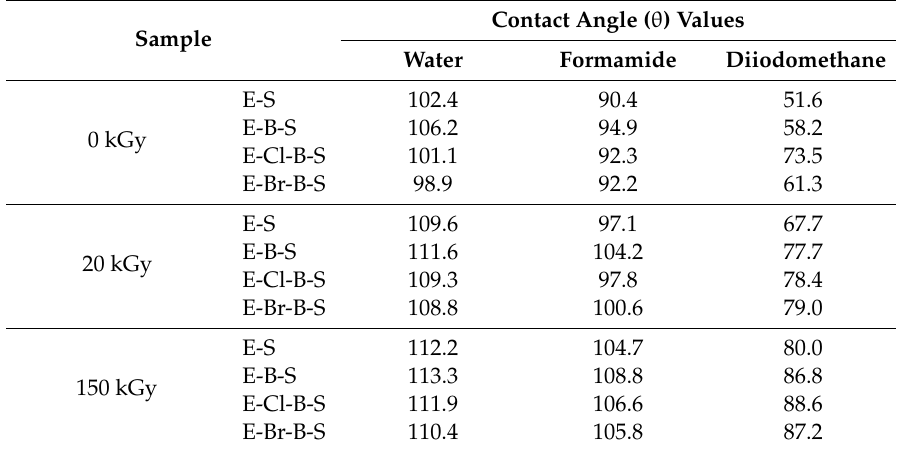
Table 5. Contact angles ( θ ) with test liquids of sample surfaces before and after electron beam irradiation. Contact Angle ( θ ) Values Sample Water